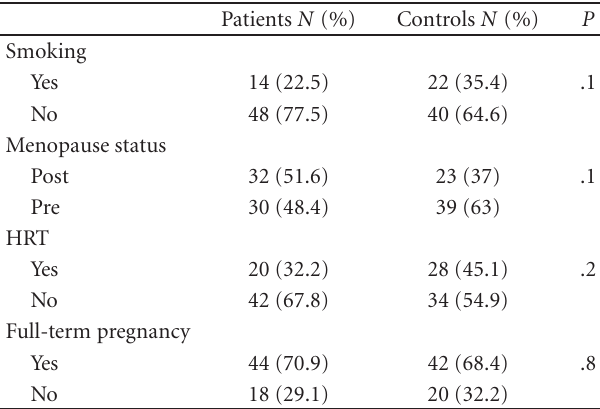
Table 1: Characteristics of breast cancer patients and